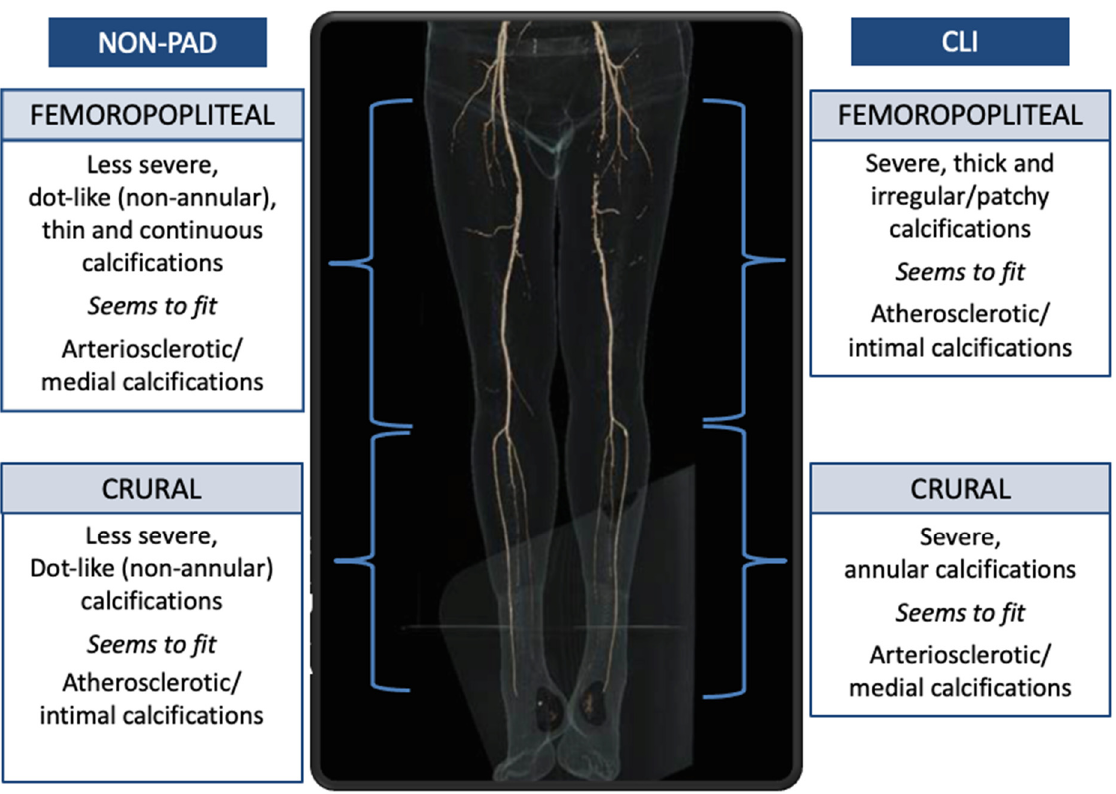
Figure 4. Schematic representation of the different calcification patterns between CLI and non-PAD patients.